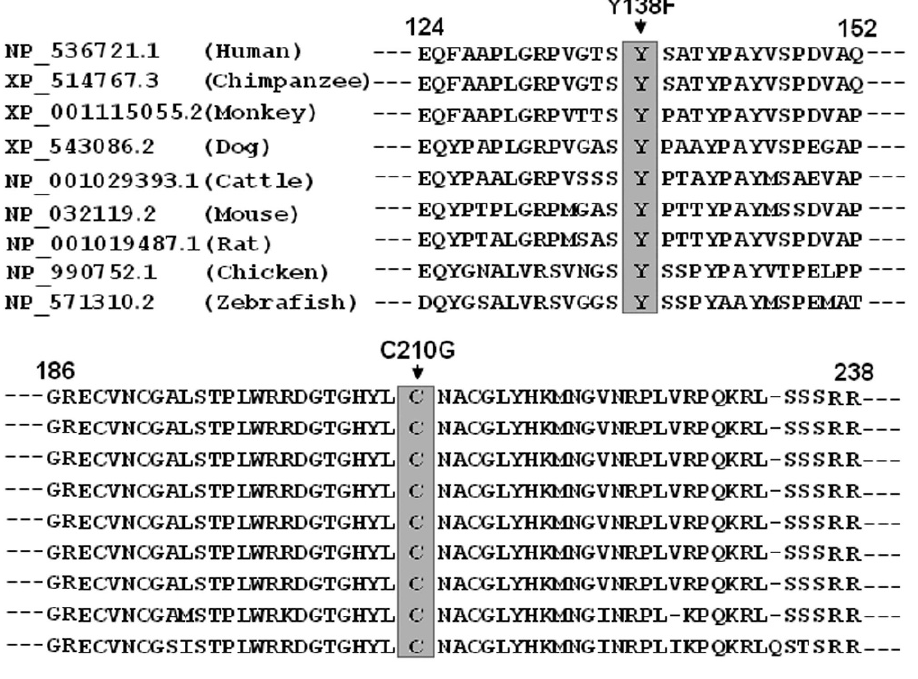
Figure 3 - Alignment of the GATA5 protein sequence of multiple species. The amino acids altered as a result of the described mutations (p.Y138 and p.C210) are completely conserved